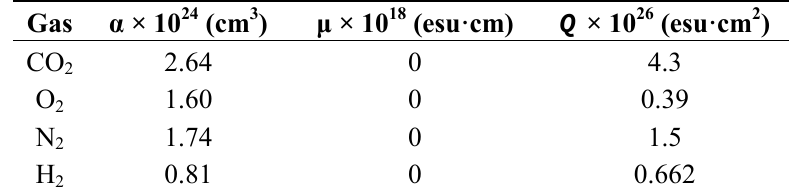
Table 4. Polarizability ( α ); dipole moment ( μ ); and quadrupole moment ( Q ) for CO O , and H . Reproduced with permission from [39,40]. Copyright 1999, Prentice Hall PTR 2 2 and Copyright 1966, Taylor and Francis